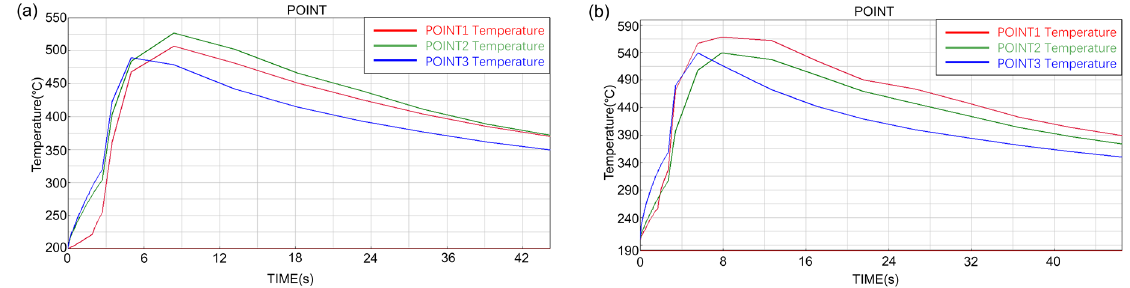
Figure 10. The temperature–time curve of the inner surface of long ring ( a ) and short ring ( b ).